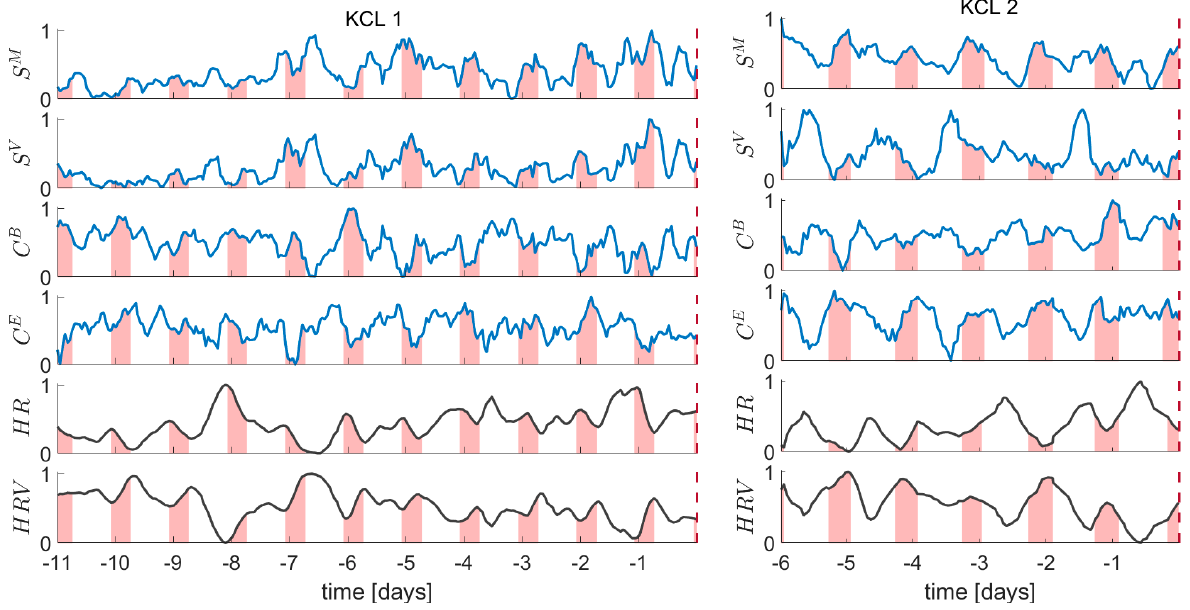
Figure 2. Temporal evolution of the EEG metrics in the alpha band (mean strength S M ; variance of strength S V ; average betweenness centrality C B ; average eigenvector centrality C E ) and ECG metrics (heart rate HR; heart rate variability HRV) for the KCL 1 and KCL 2 participants. Vertical dashed red line indicates the timestamp of the seizure. Shaded areas denote the 0:00 a.m.–8:00 a.m. time interval.